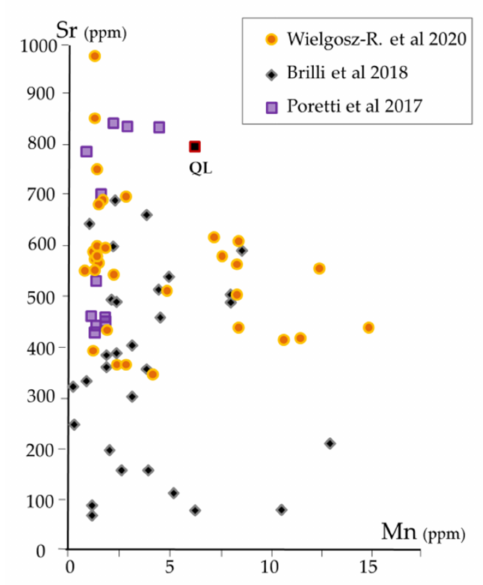
Figure 10. Scatterplot of the concentration of strontium and manganese (units in ppm) of the white Göktepe marble modified from [15], with additional data from [17,25] and the QL sample under study (red and black